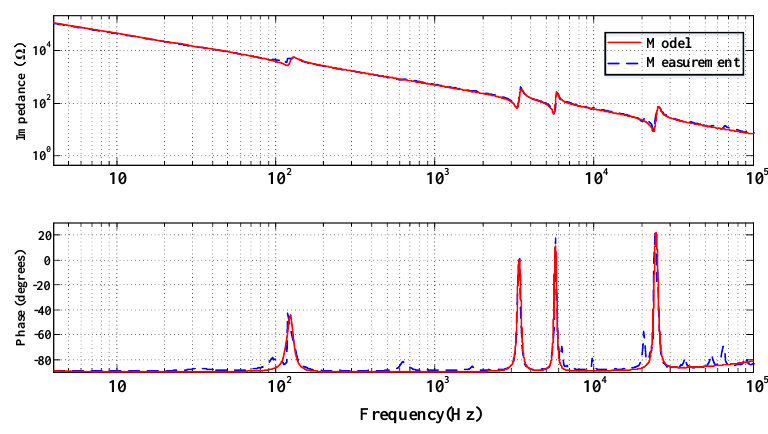
Figure 2. Impedance characteristic of one layer of bimorph.